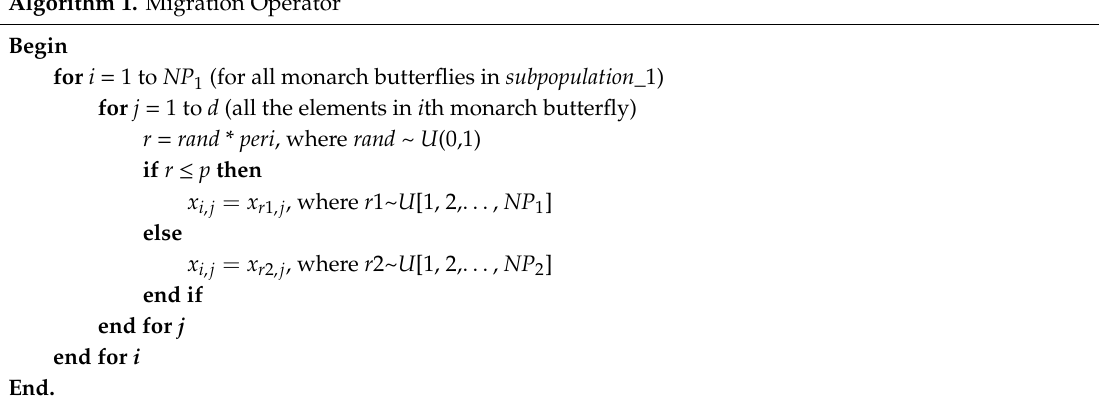
Algorithm 1. Migration Operator